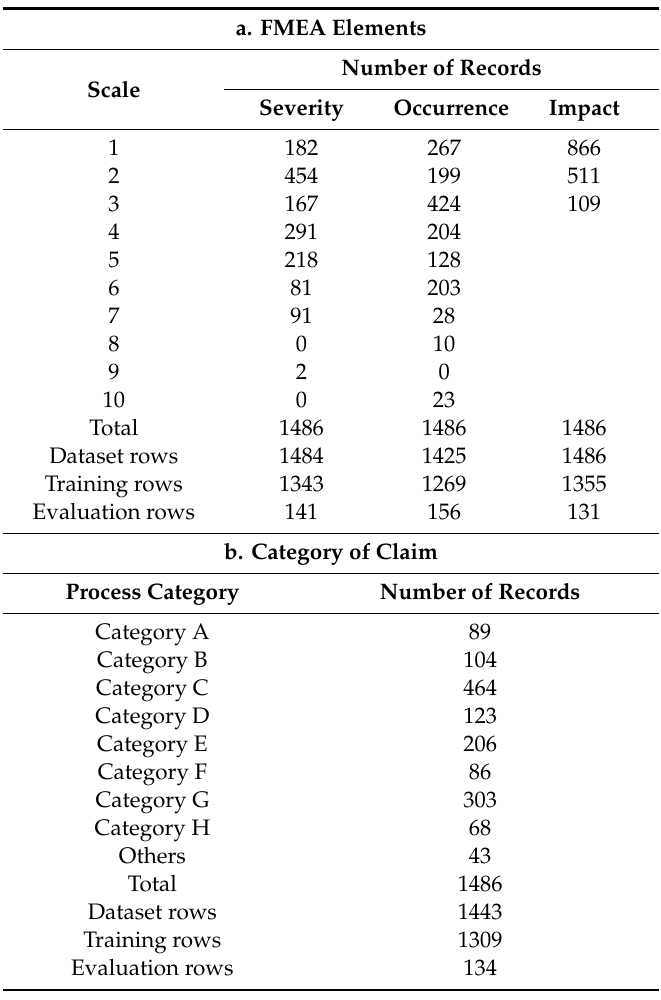
Table 2. Summary of dataset included in the